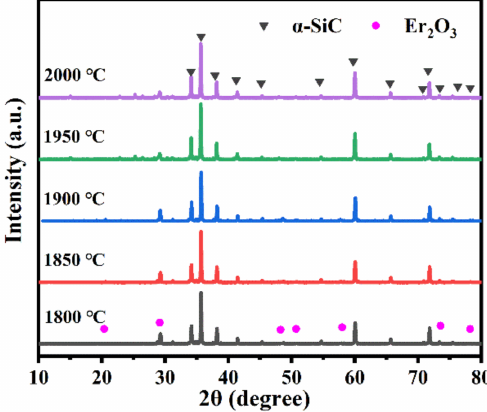
Figure 1. XRD patterns of SiC ceramics sintered at di ff erent